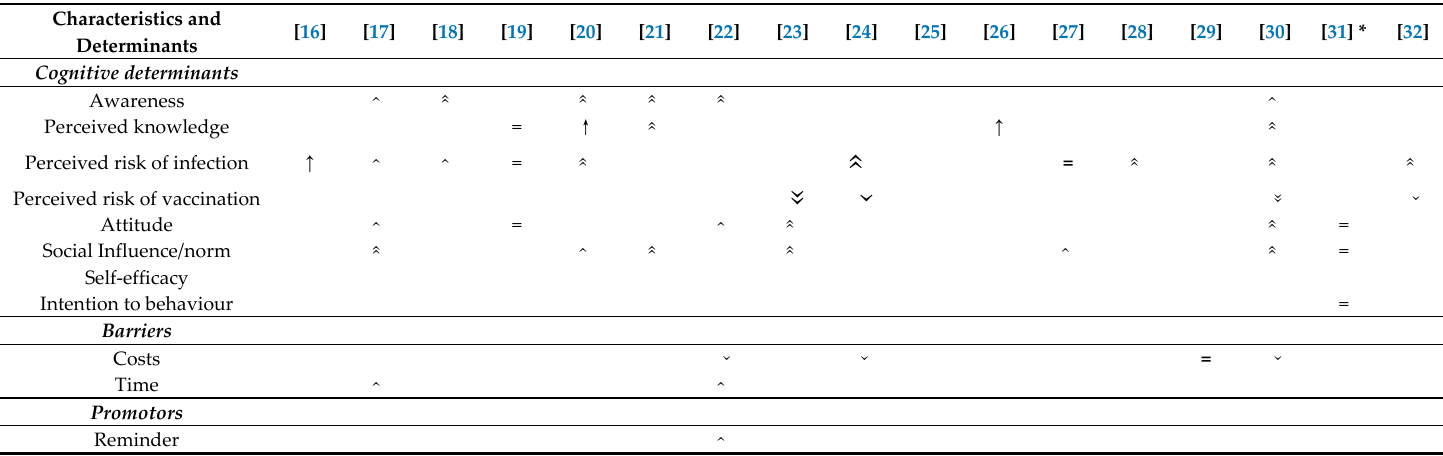
Table 2. Cont. Vaccines 2020 , 8 , x FOR PEER